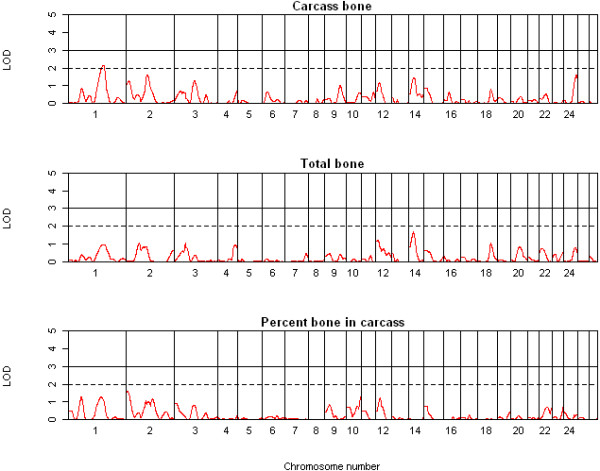
QTL map of the entire genome for total bone, carcass bone and bone percentage.